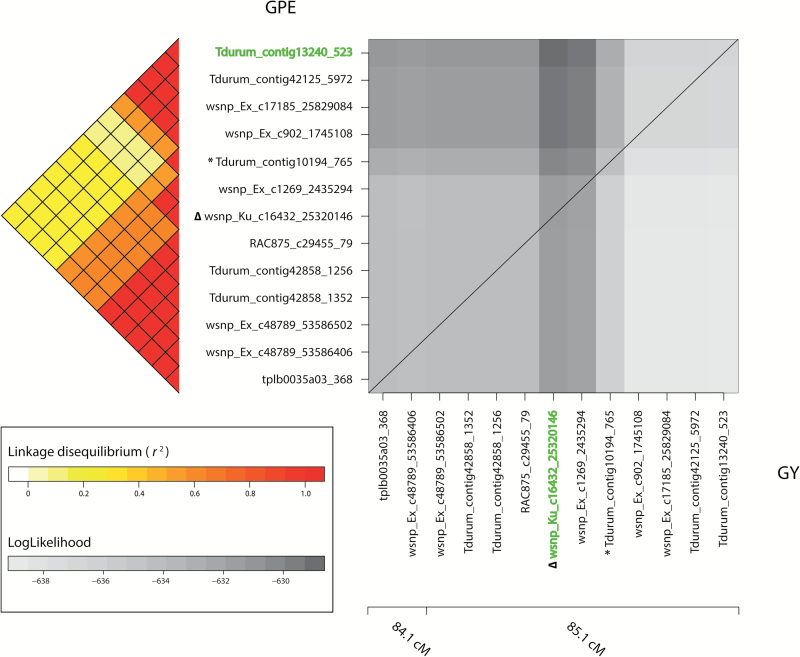
Landscape of bivariate likelihoods (log-likelihoods) during the two-dimensional scan to distinguish close linkage from pleiotropy in the vicinity of Tdurum_contig10194_765 (indicated with an asterisk), a locus simultaneously associated with grain yield (GY) and grains per ear (GPE) on chromosome 6A (Fig. 1A; Supplementary Table S8). Likelihoods pertaining to pleiotropy models were maximized at marker wsnp_Ku_c16432_25320146 (denoted with Δ), whereas likelihoods for linkage models were maximized at the combination of wsnp_Ku_c16432_25320146 and Tdurum_contig13240_523 (highlighted in green), with these last two markers carrying the effects on GY and GPE, respectively. The log-likelihood ratio test of Jiang and Zeng (1995) using maximized likelihoods rejected H0: p(1)=p(2) of pleiotropy at the nominal significance level of 0.05.